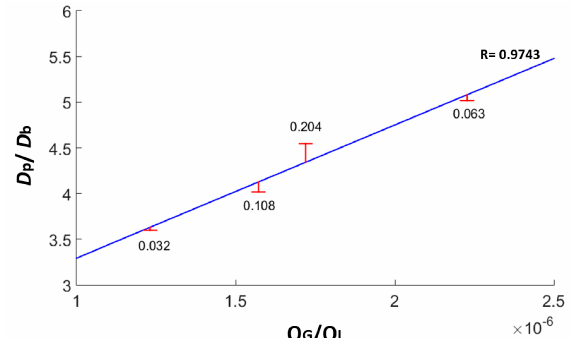
Figure 10. Microbubble production linearity in relation to gaseous and liquid phase flow. In which, D b is the generated microbubbles’ mean diameter, D p is the micropipette’s diameter (i.e., the diameter of the gas channel), Q g is the gaseous phase flow rate, and Q l is the liquid phase flow rate. The graph shows a linear trend with a Pearson correlation coefficient (R) of 0.9743.